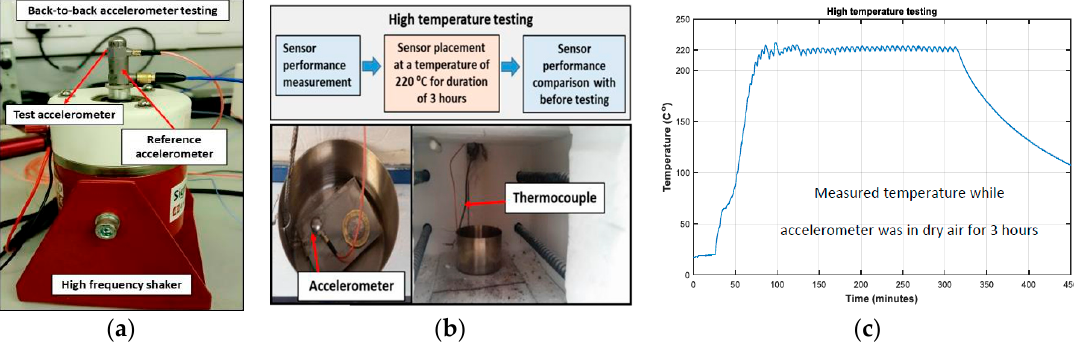
Figure 1. ( a ) Back-to-back accelerometer testing to measure performance spectrum of test accelerometer with respect to reference accelerometer. ( b ) Schematic and photograph for high temperature testing. ( c ) Measured temperature for accelerometer high temperature testing inside